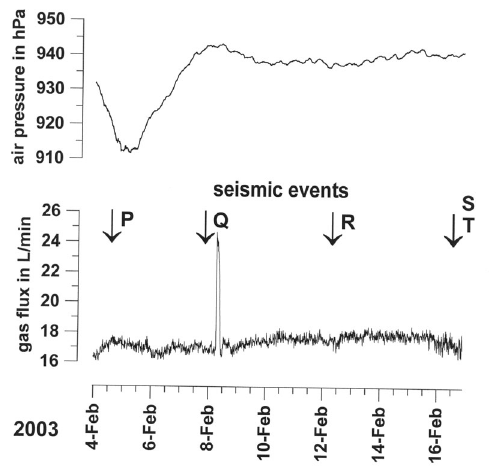
Fig. 7. Temporal variation of the gas flux and at- mospheric pressure recorded at the Tramutola station in the period from February 4 to February 16, 2003. P, Q, R, S and T are local seismic events in that period.